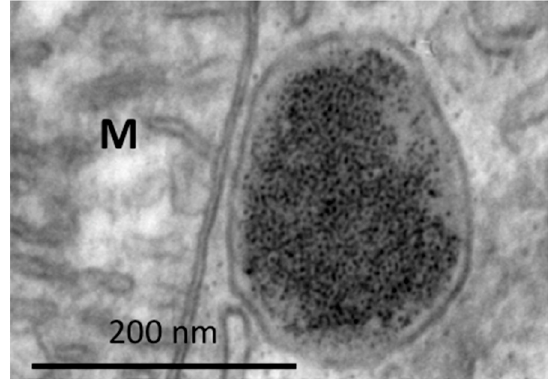
Figure 4. Representative transmission electron micrograph exemplifying an endosome within the cytoplasm of a cell. M denotes a mitochondrion in the vicinity of the endosome, which is laden with magnetic nanoparticles. Structurally, the nanoparticles within endosomes resemble MNCs.